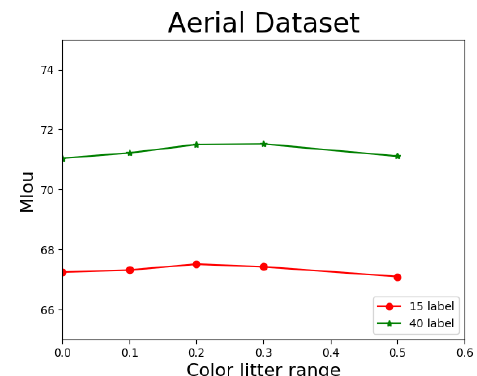
Figure 4. Semi-supervised experimental results of different color jitter ranges on INRIA Aerial dataset.